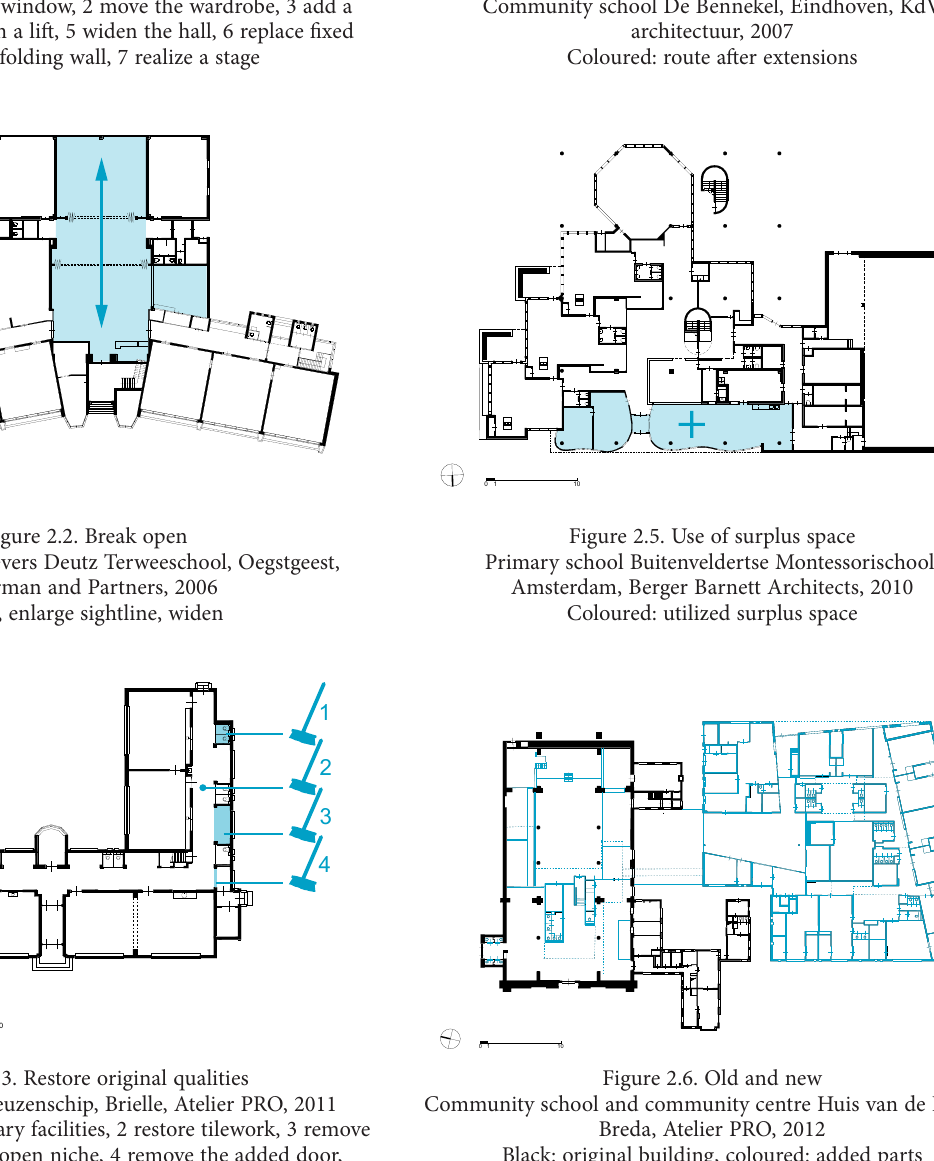
Figure 2.4. Continue route Community school De Bennekel, Eindhoven, KdV architectuur, 2007